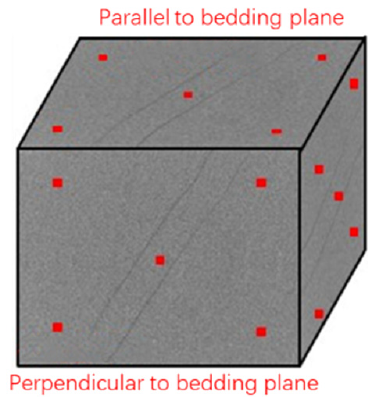
Figure 2. Schematic diagram of SEM observation position of the rock sample.